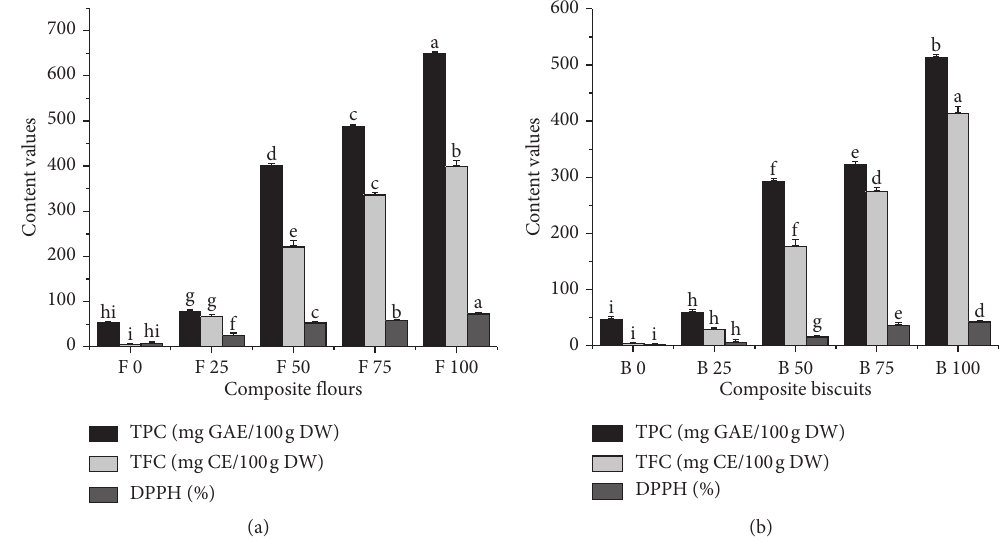
Figure 3: Total phenolics, total flavonoids, and antioxidant activity of flour and biscuit samples. Values indicated by different lowercase letters are significantly different ( p < 0 . 05) according to Tukey’s